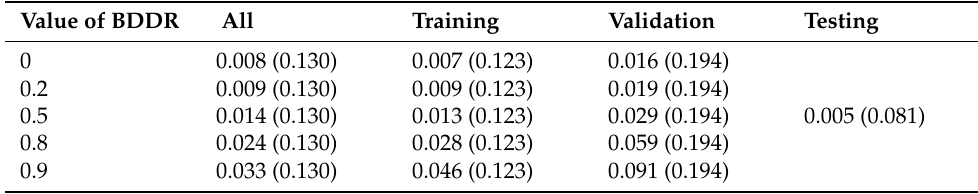
Table 5. MDR of data set after dropping background